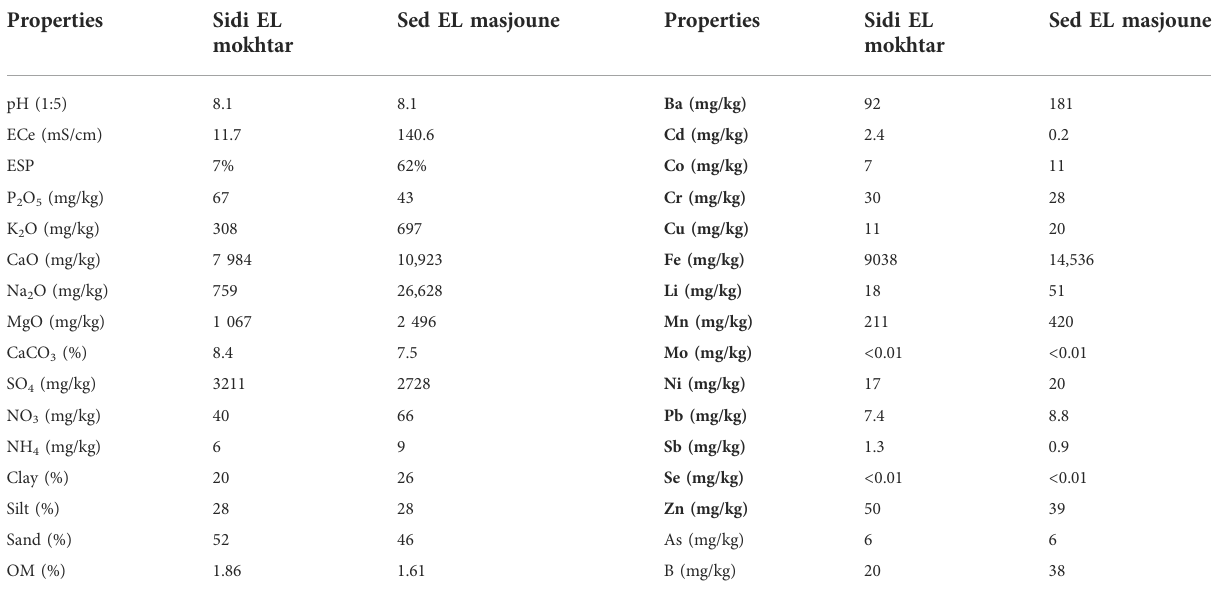
TABLE 1 Chemical characteristics of soils.